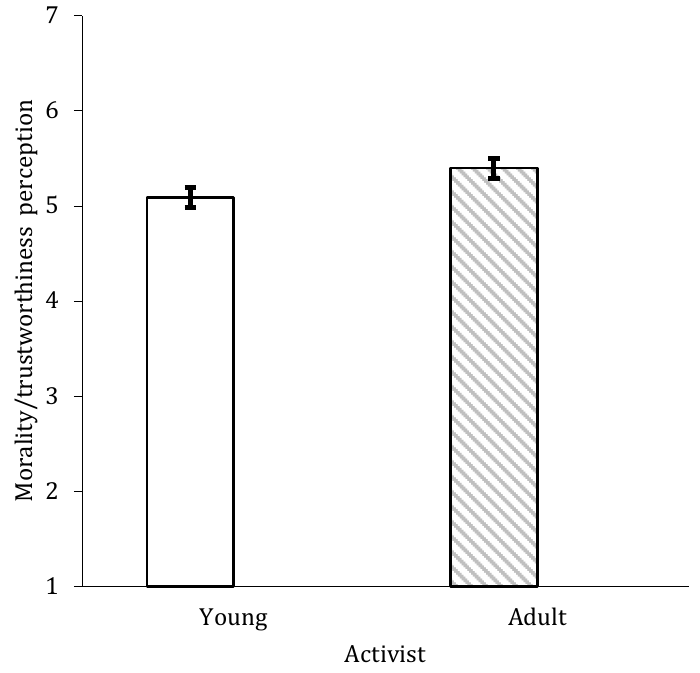
Figure 8. Means and standard errors regarding morality/trustworthiness by experimental conditions.